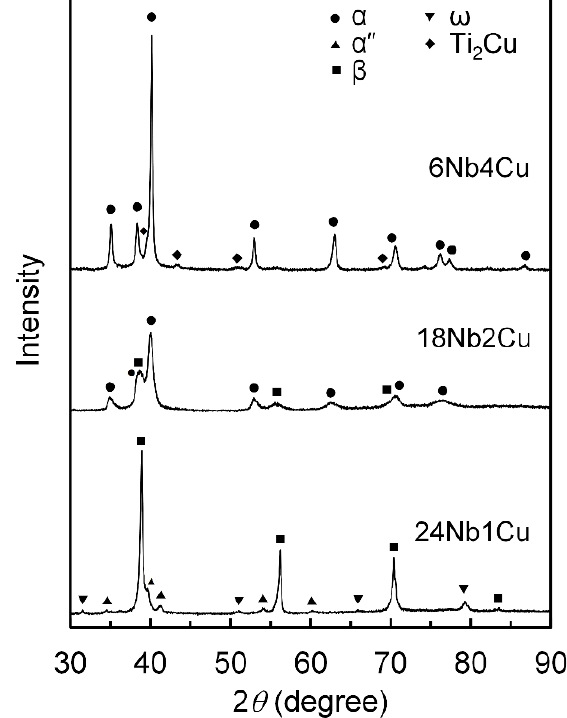
Figure 1. X-ray diffraction patterns obtained from Ti − Nb − Cu alloys. Figure 1. X- ray diffraction patterns obtained from Ti−Nb−Cu alloys.